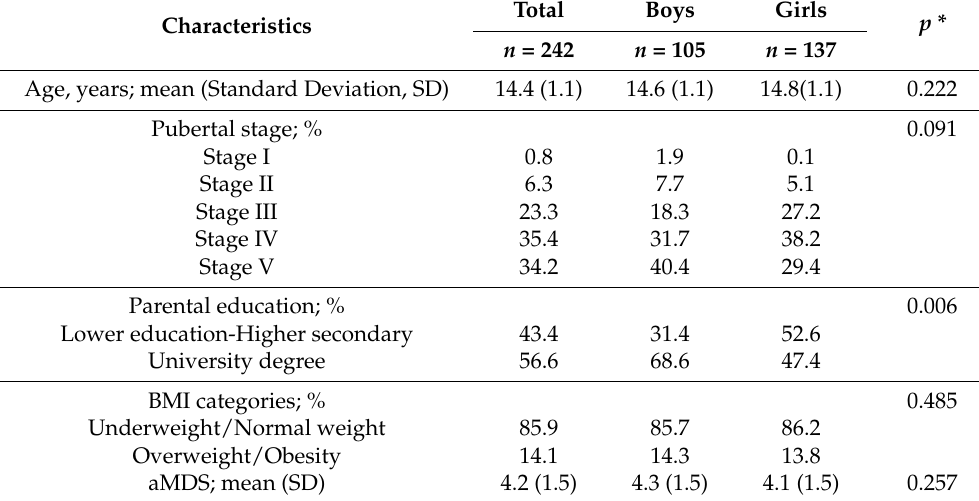
Table 1. Characteristics of the adolescent population